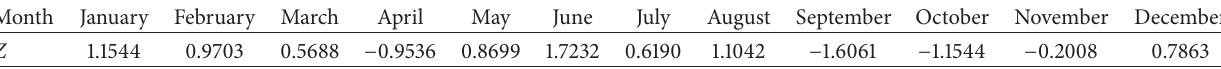
Figure 2: Temporal annual precipitation (a) and rainy days (b) for the Huaihe River basin. Table 3: Mann-Kendall statistic values for monthly precipitation.